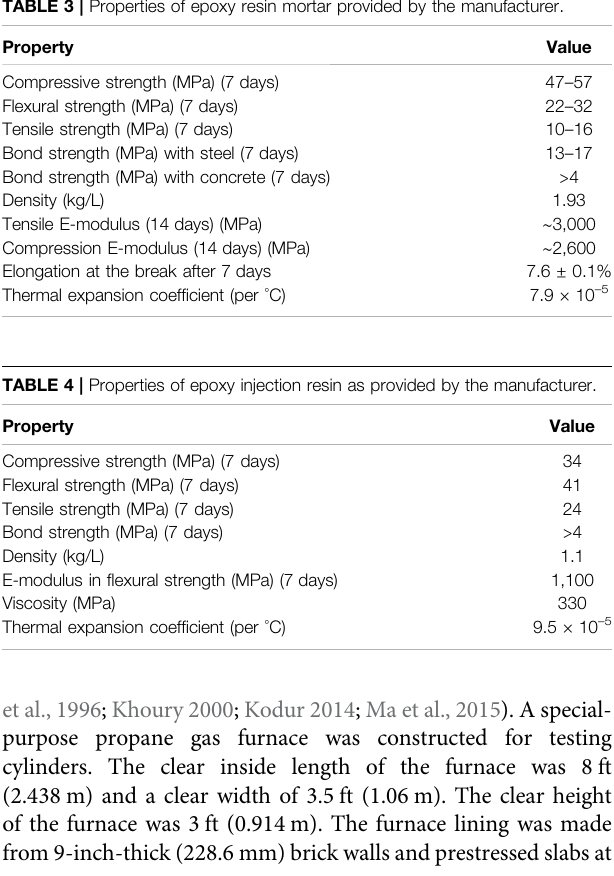
TABLE 3 | Properties of epoxy resin mortar provided by the manufacturer.